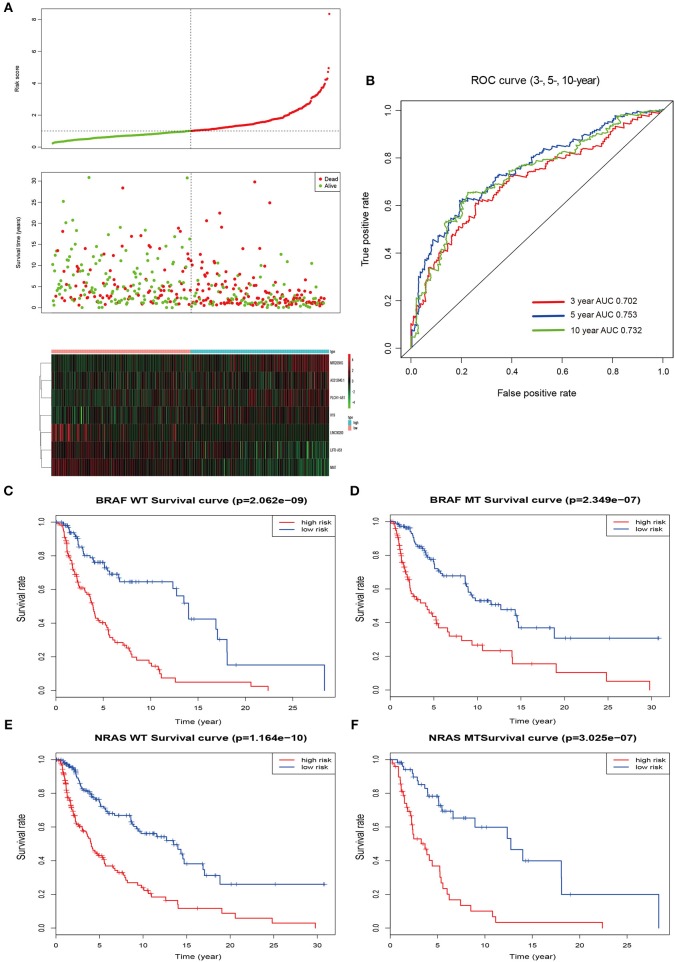
Risk score by the 7-lncRNA signature, time-dependent ROC curve and Kaplan–Meier survival analysis. (A) The distribution of the risk score, survival status, and 7-lncRNA signature. (B) ROC curve was plotted for 3-, 5-, and 10-year overall survival in melanoma. red, 3-year; blue, 5-year; green, 10-year. (C,D) Kaplan–Meier estimates of the overall survival of patients carrying wild-type and mutant BRAF. (E,F) Kaplan–Meier analysis estimates the overall survival of patients carrying wild-type and mutant NRAS. WT, wild type; MT, mutation; red, high risk; blue, low risk.